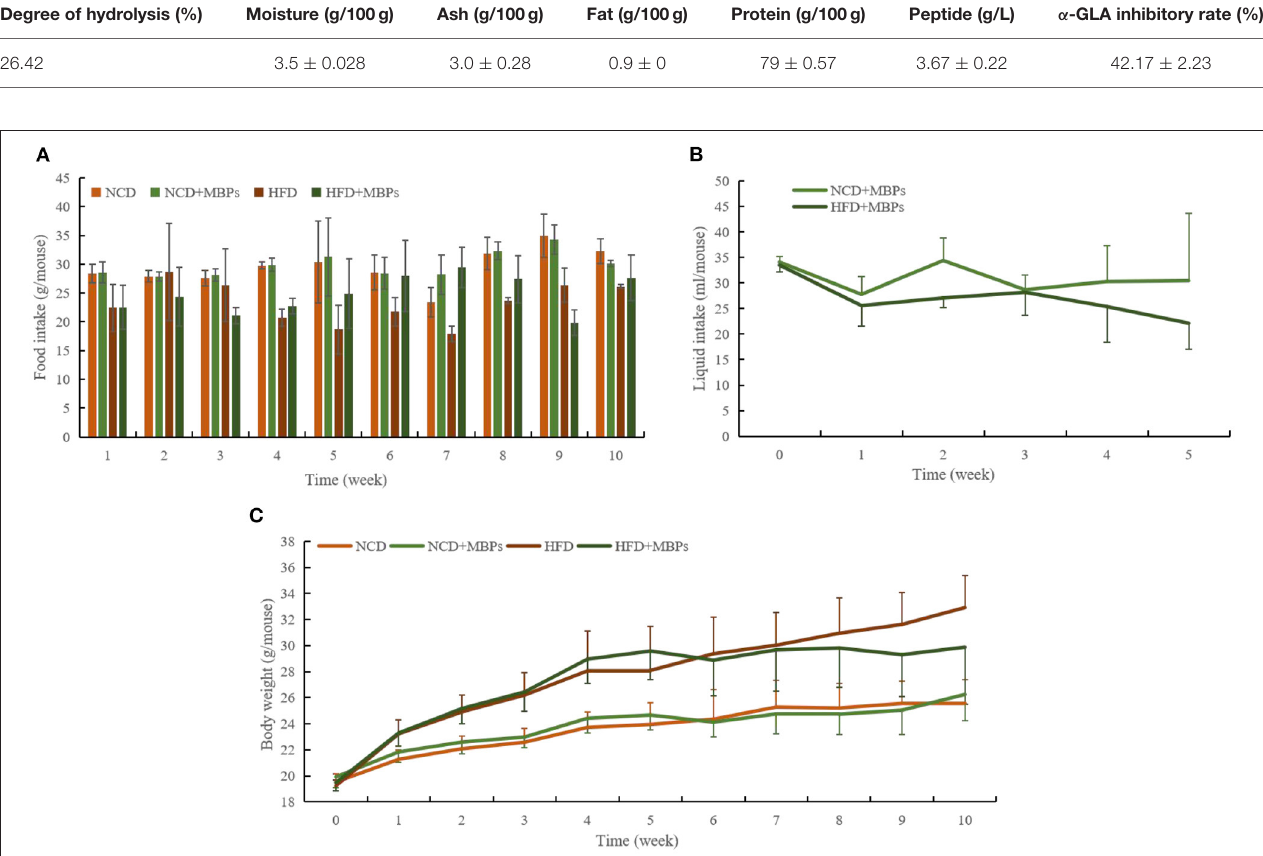
FIGURE 2 | Effects of MBPs on (A) food intake, (B) water intake, and (C) body weight in different mice groups. Data were presented as the mean ± SD ( n = 10).